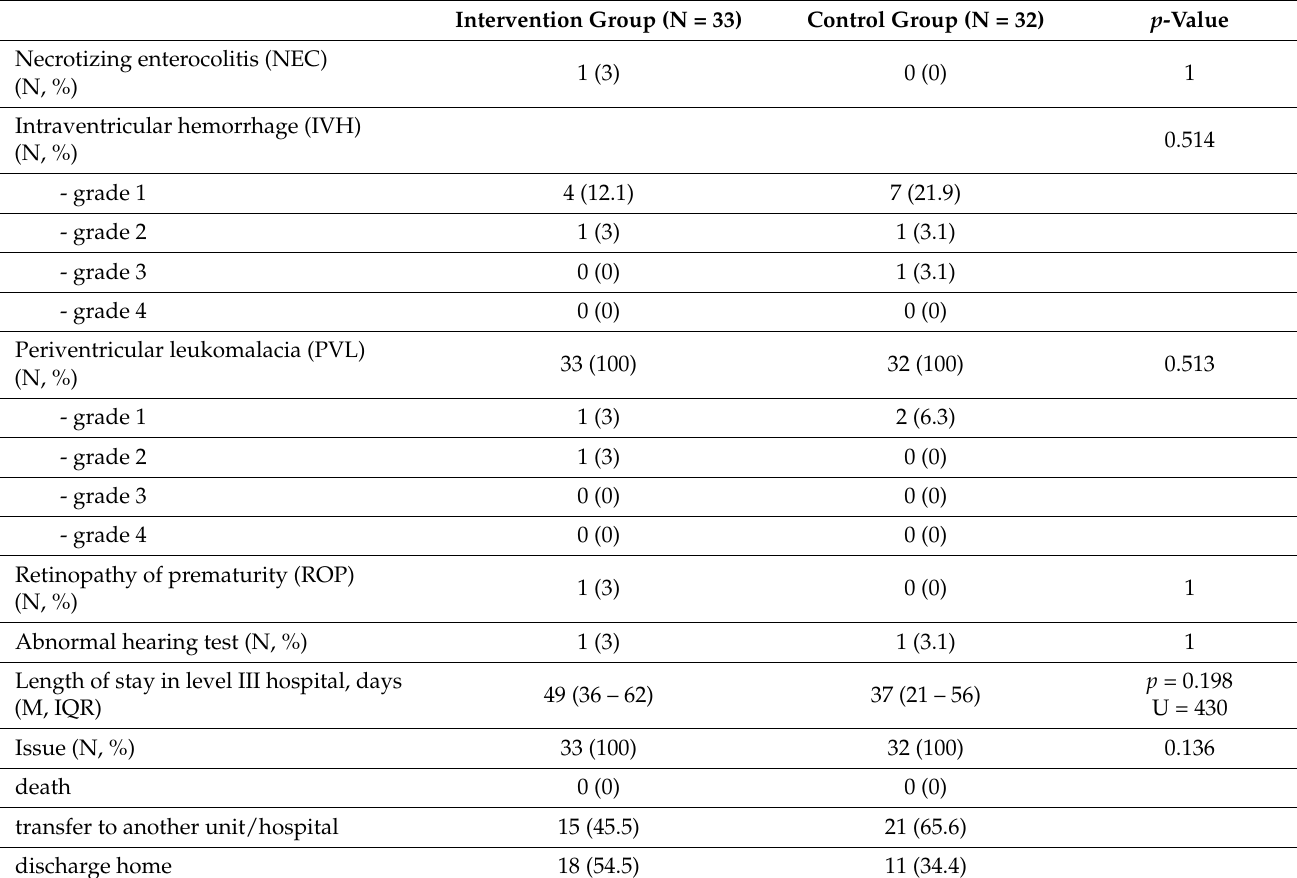
Table 1. Cont. Intervention Group (N =